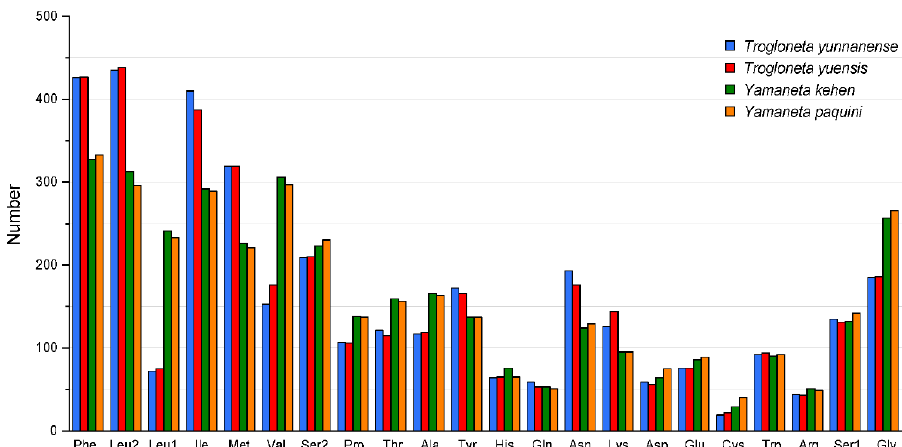
Figure 2. Amino acid frequency of PCGs in the Trogloneta and Yamaneta mitogenomes.